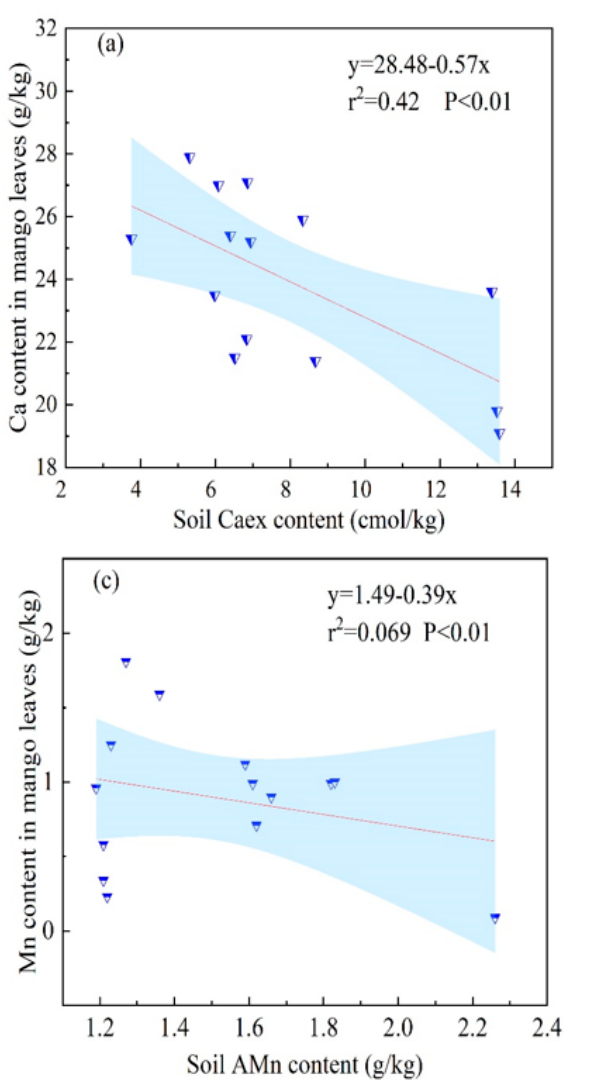
Figure 4. Uptake and utilization relations of Fe, Mn, and Ca elements in mango. ( a ) Relationship between Caex content in soil and Ca content in mango leaves, ( b ) Relationship between AFe content in soil and Fe content in mango leaves, ( c ) Relationship between AMn content in soil and Mn content in mango leaves.